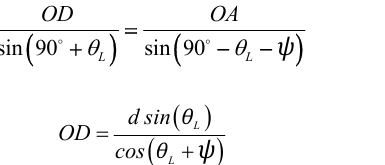
Figure 1. Footprint of convergent image and schematic details of building corner O (exterior angle of 55°, camera position C, and points P and Q on circular path, and image footprint by OD, and OE). In above figure, lines OP and OQ are of equal lengths. Line OP and OQ are normal to left and right wall surfaces, respectively.